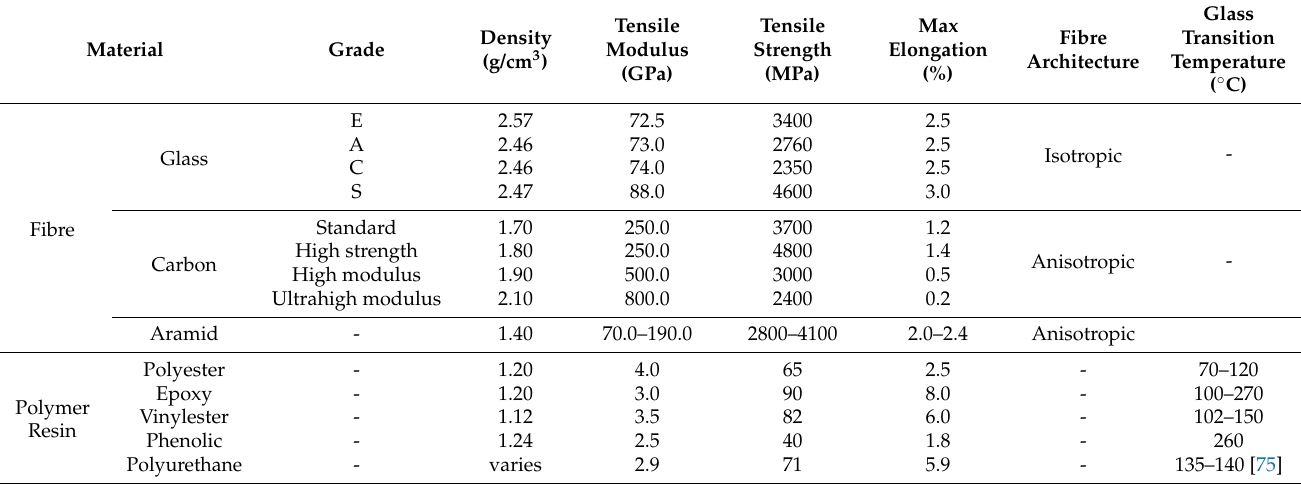
Table 1. Properties of fibres and thermosetting polymer resins